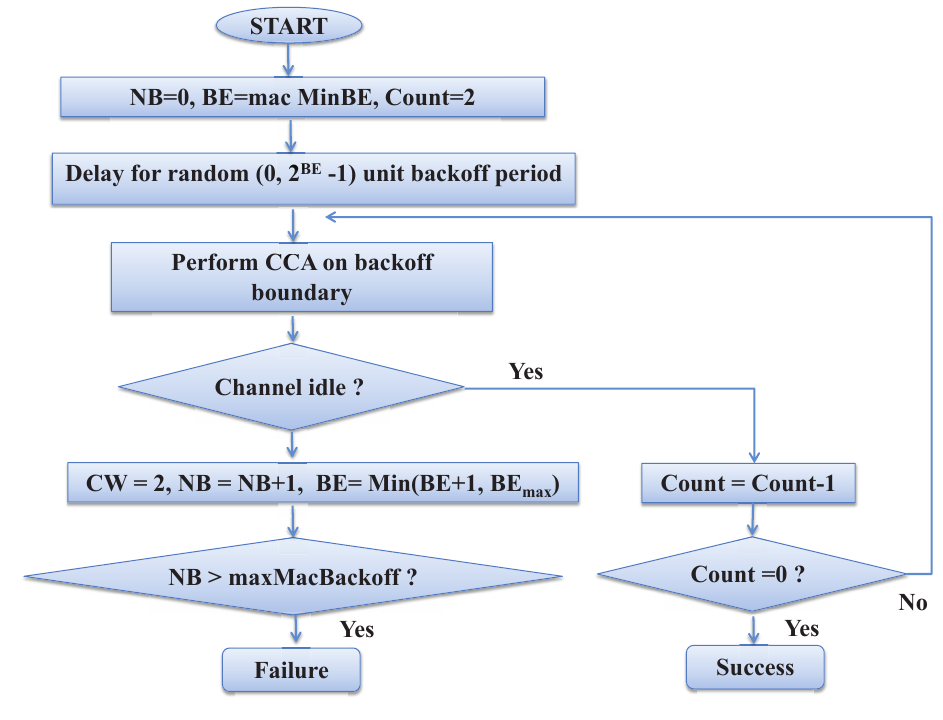
Figure 2. Channel access mechanism of IEEE